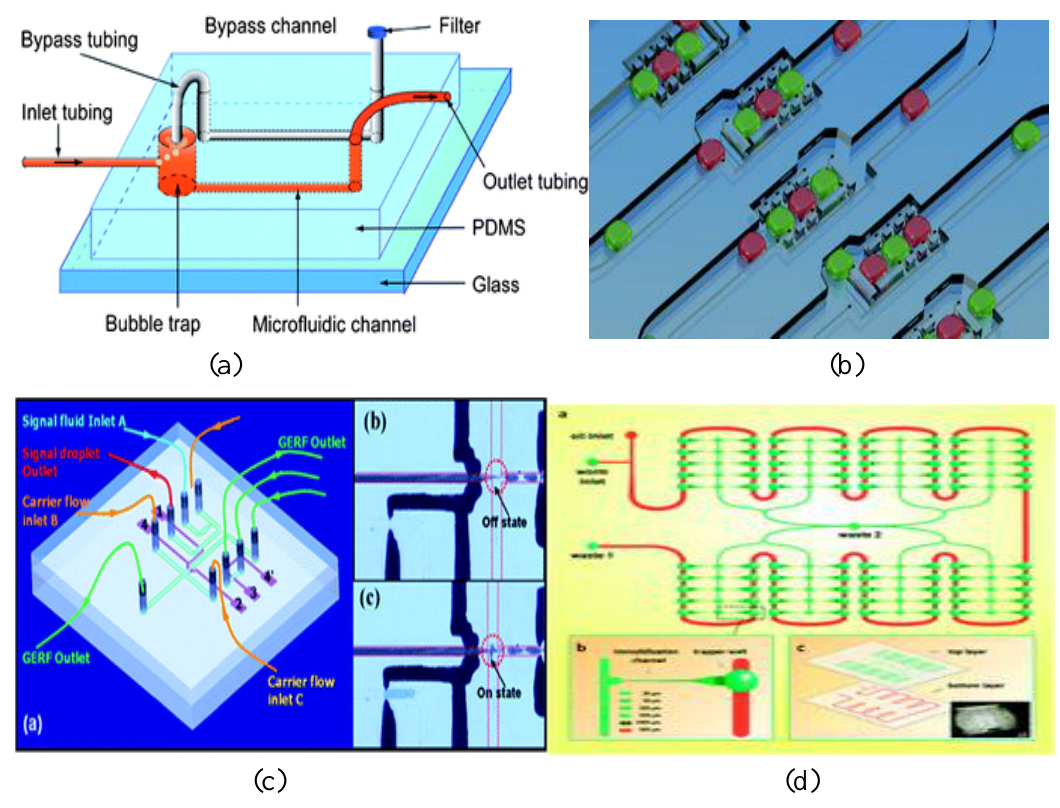
Figure 2. (a) Integrated bubble trap (IBT) [29]; (b) Microfluidic droplet-based